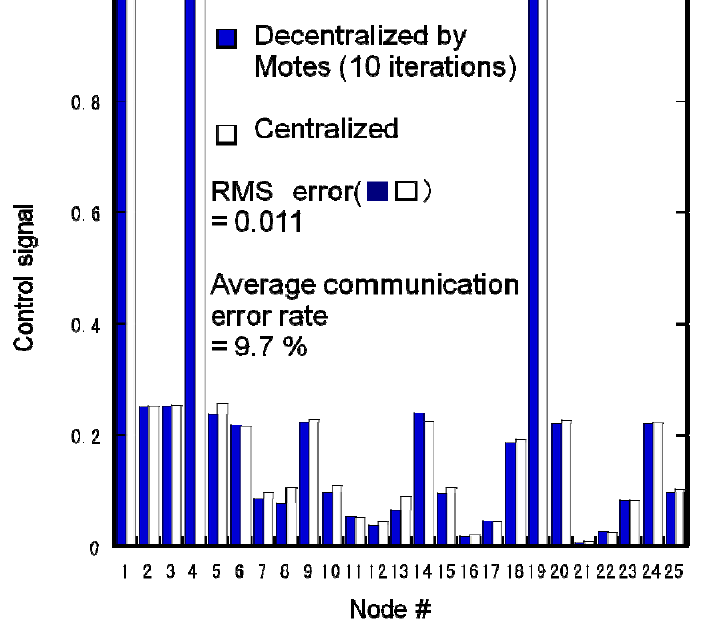
Figure 10. Experimental distributed actuation results obtained using Motes implemented with proposed decentralized algorithm and simulation of centralized